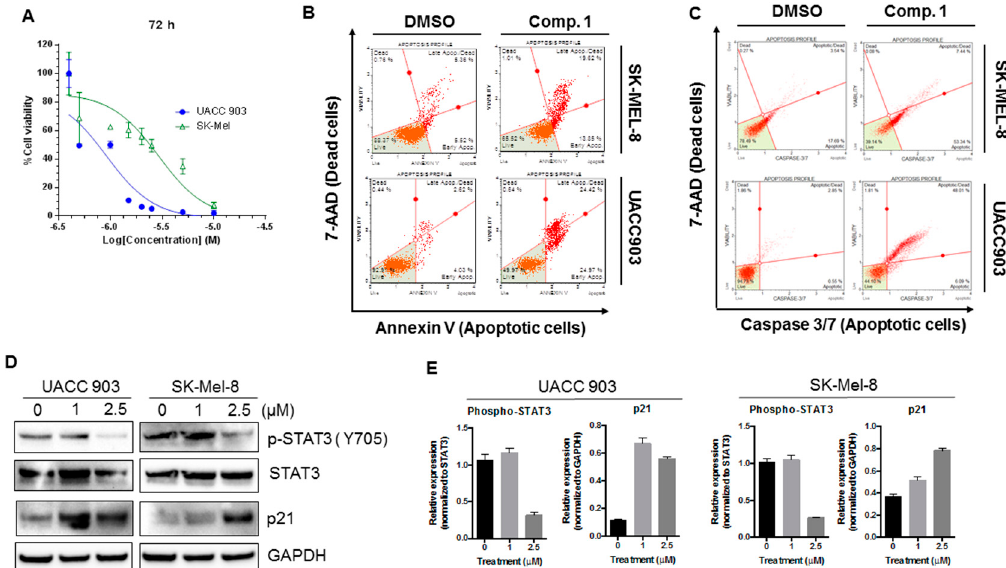
Figure 7. Compound 1 inhibited the phosphorylation of STAT3, increased the expression of p21, and induced apoptotic cell death in UACC 903 and Sk-Mel-8 melanoma cell lines. ( A ) Cell viability (MTT) results for compound 1 in two different melanoma cell lines at 72 h. The graphs were obtained by performing non-linear regression analysis using variable slope. Error bars represent mean ± SD. ( B , C ) Human melanoma cells UACC 903 and SK-Mel-8 were treated with compound 1 (2.5 µ M) for 24 h, and an apoptotic assay was performed using the Muse TM Annexin V & Dead Cell ( B ) and Caspase 3/7 Kit ( C ) according to the manufacturer’s instructions. ( D ) Melanoma cells (UACC 903 and SK-Mel-8) cells were treated with the mentioned concentrations of Compound 1. After 24 h, cells were collected and lysed, and the expression of p-STAT3, STAT3, and p21 was analyzed by western blot. GAPDH was used as a loading control; ( E ) Quantification of protein expression was performed using Image J software, and graphs represent the relative expressions of proteins. The relative expressions were determined using either STAT3 or GAPDH as